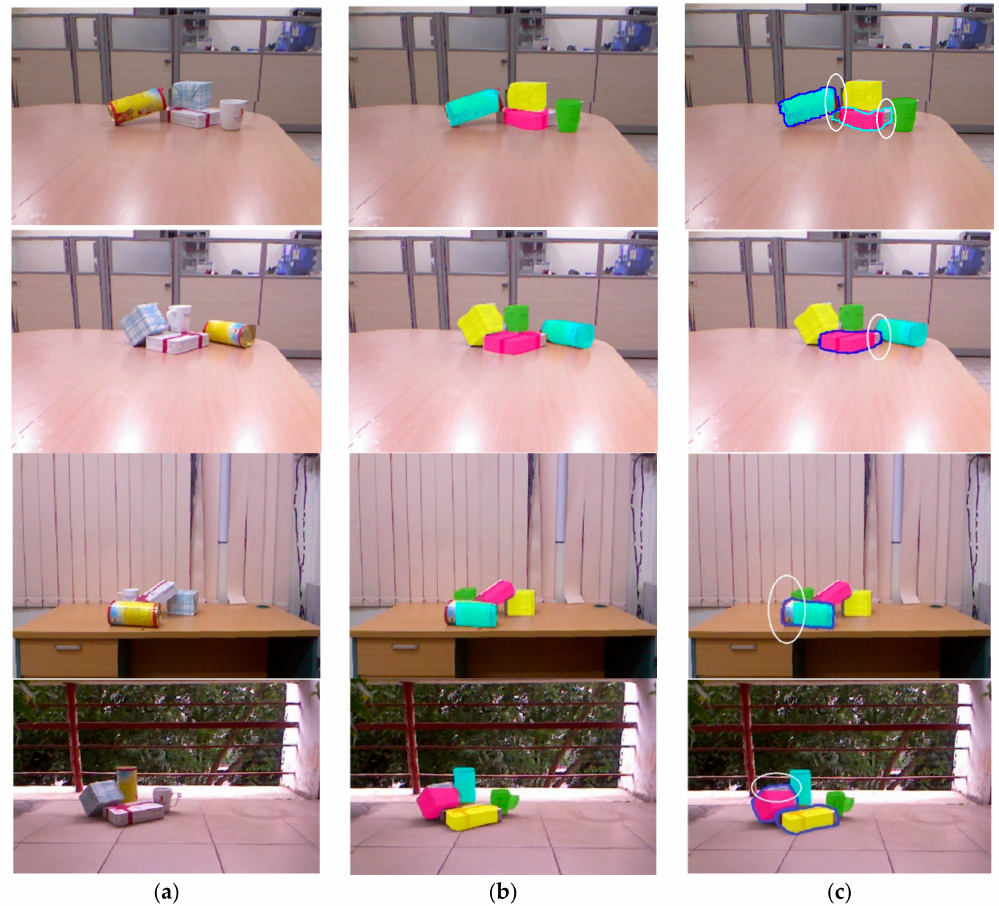
Figure 7. The comparison image between ( a ) original images, ( b ) Mask R-CNN and ( c ) our approach. Our approach can find all the borders of the object, as shown in the white